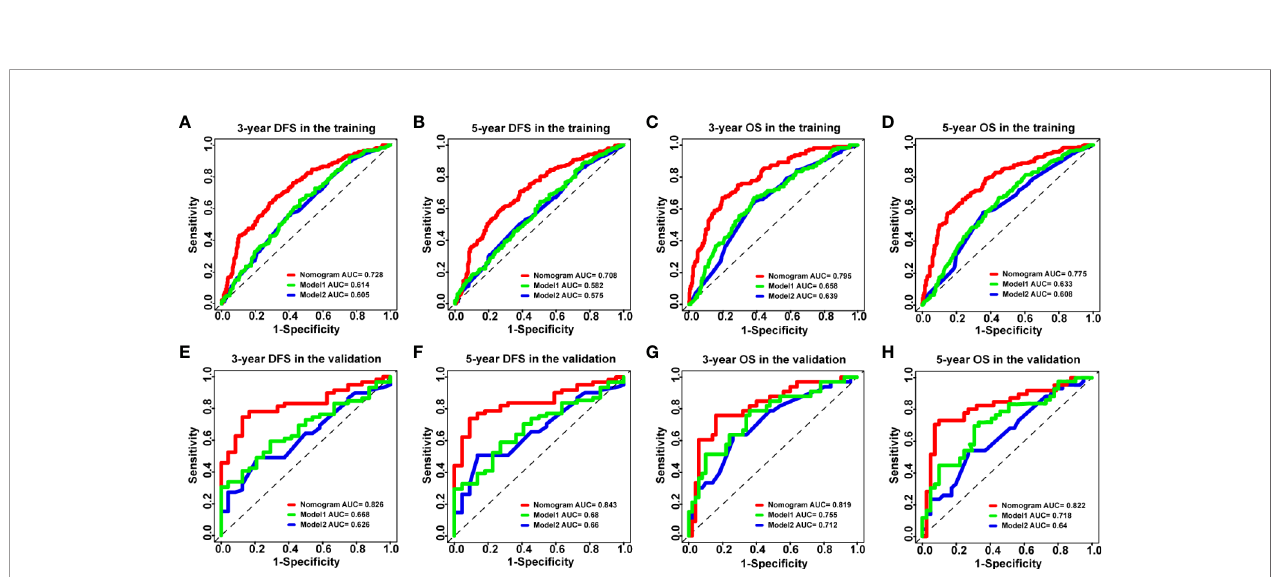
FIGURE 4 | The ROC curves of the nomogram models and other models in HCC patients. (A – D) ROC curves showing the discriminatory abilities of the nomogram models and other models for the 3-year DFS (A) and OS (C) rates and 5-year DFS (B) and OS (D) rates in the training cohort. (E – H) ROC curves showing the discriminatory abilities of the nomogram models and other models for the 3-year DFS (E) and OS (G) rates and 5-year DFS (F) and OS (H) rates in the validation cohort. GPR, gamma ‐ glutamyl transpeptidase ‐ to ‐ platelet ratio; ALB, albumin; ROC, receiver operating characteristic; HCC, hepatocellular carcinoma; DFS, disease- free survival; OS, overall